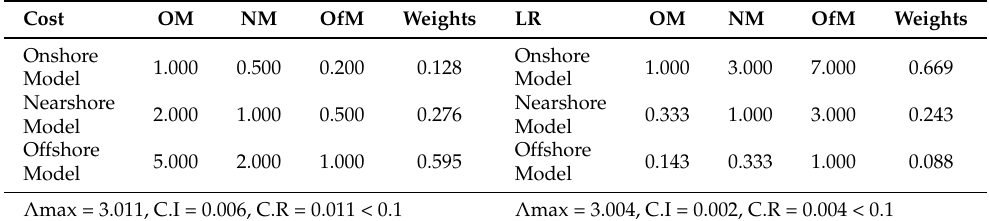
Table 9. Weights of the alternatives with respect to costs and legal requirements.